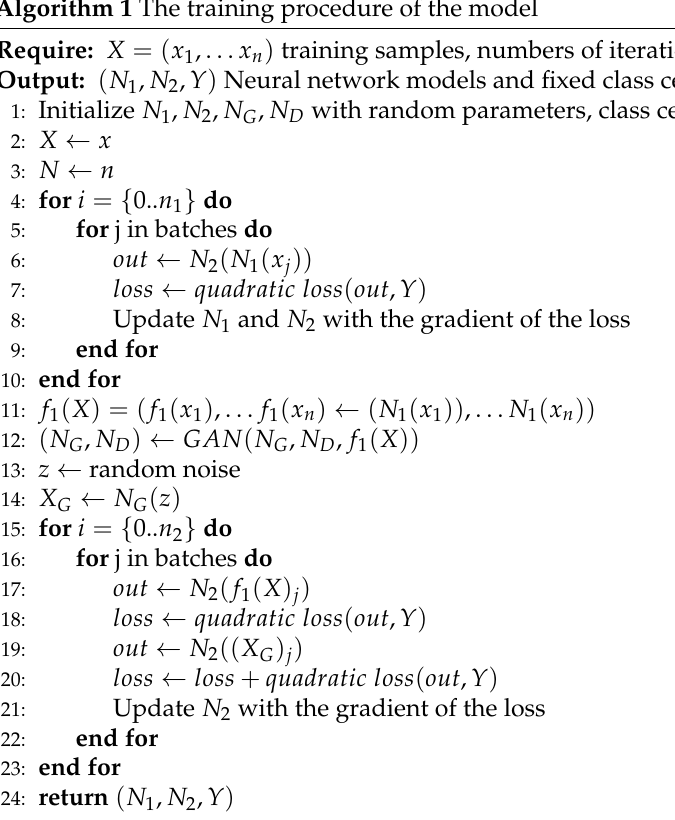
Algorithm 1 The training procedure of the model